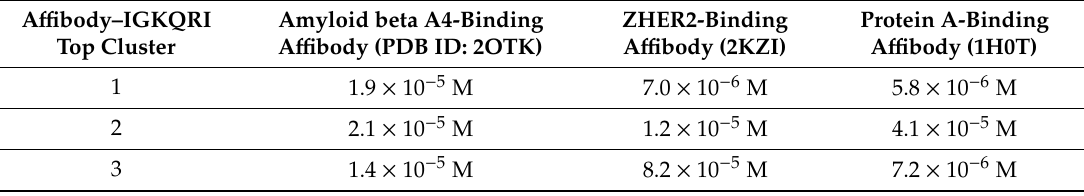
Table 5. Values of binding a ffi nity (K D,in silico , calculated using Equation (2) from molecular dynamics (MD)-derived values of ∆ G B , Section 5.2.11) of the top 3 a ffi body–IGKQRI clusters obtained by docking the peptide IGKQRI on amyloid beta A4 protein-binding a ffi body, ZHER2-binding a ffi body,